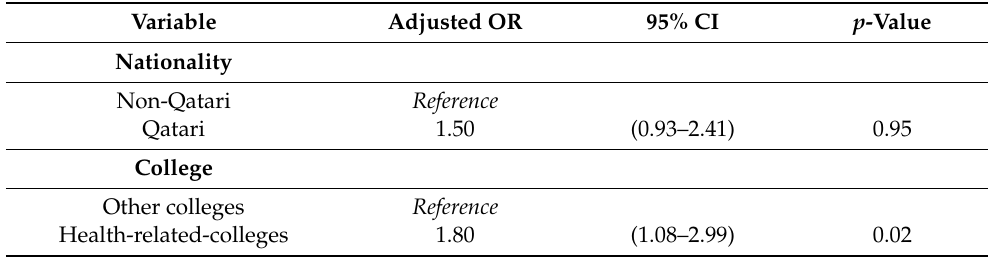
Table 4. Adjusted odds ratio (OR) of attitude (marriage cancellation in the case of PMS incompatible results) by participants’